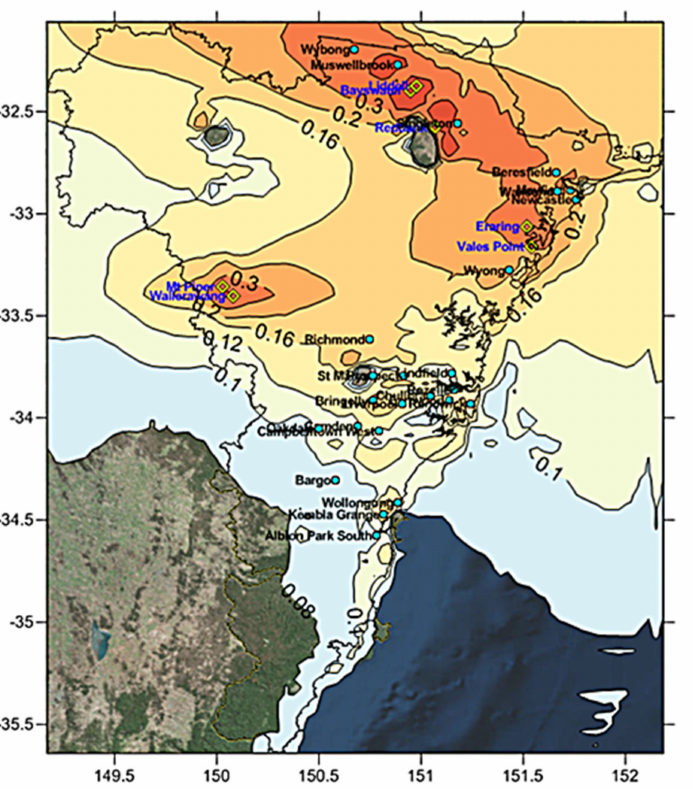
Figure 4. Predicted annual average PM2.5 concentrations ( µ g m -3 ) due to 2013 coal-fired power station boiler stack